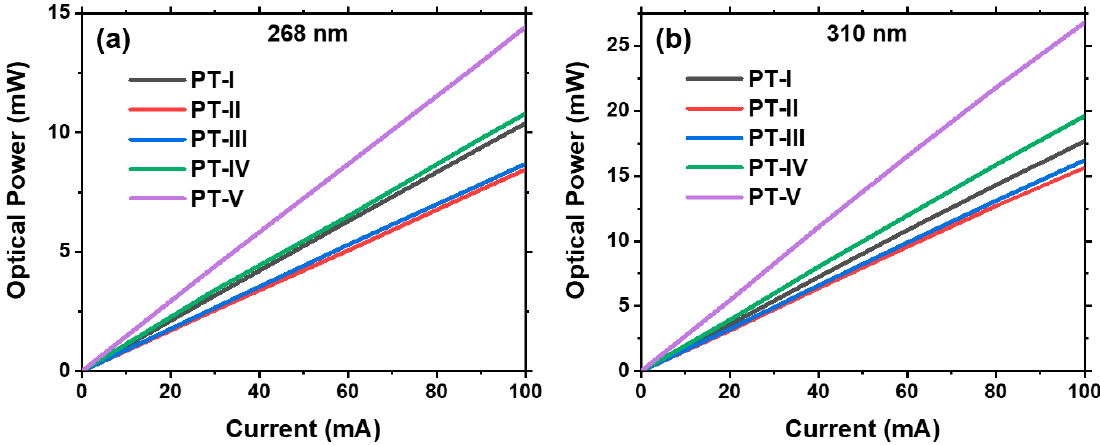
Figure 7. Optical power of the five PTs for ( a ) 268 nm and ( b ) 310 nm DUV-LEDs.